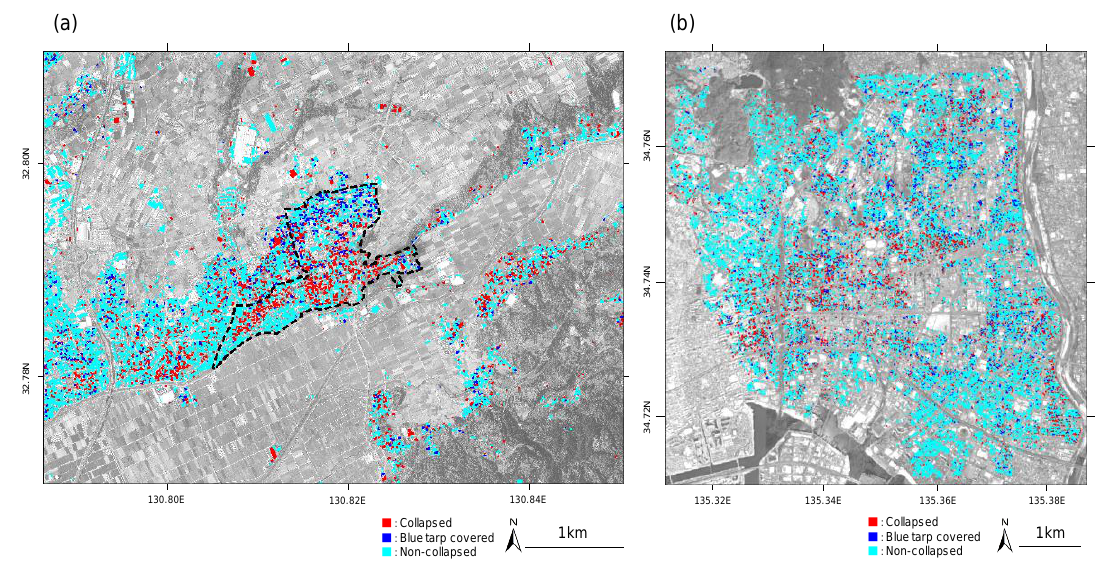
Figure 9. Damage distributions estimated by the CNN model for ( a ) Mashiki town in the 2016 Kumamoto earthquake and ( b ) Nisinomiya city in the 1995 Kobe earthquake. Table 7. Result of the CNN-based damage classification for each damage inventory. The colors of the cells indicate the labels of the classification; correctly estimated (light green), underestimated (light blue) and overestimated (pink). Accuracies for the blue tarp-covered buildings are shown by brackets since the blue tarp does not perfectly correspond to D2 – D4/moderate, heavy damage levels. (a) AIJ-data